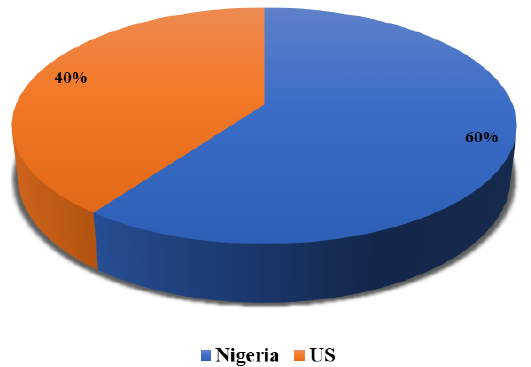
Figure 3. Survey response by country